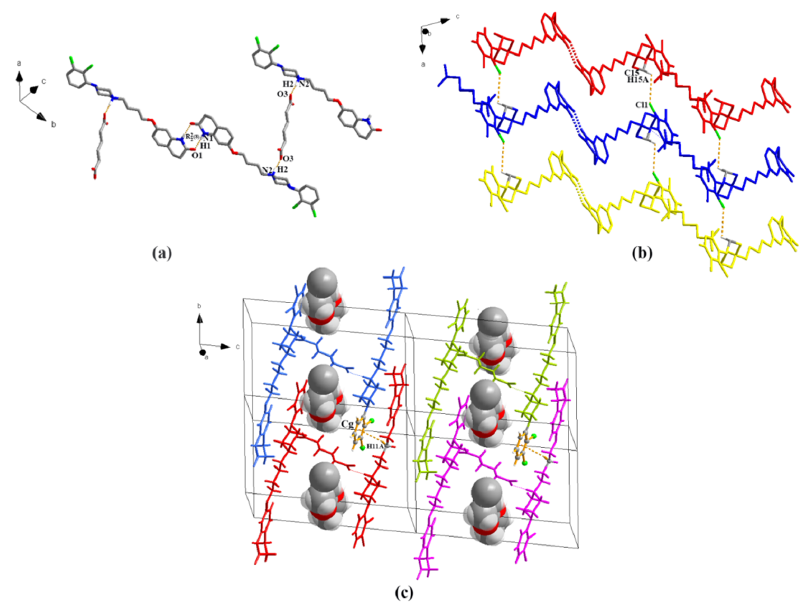
Figure 3. Packing diagrams of ARI-ADI salt acetone hemisolvate: ( a ) the 1D ribbon formed by N 1 -H 1 … O 1 and N 2 -H 2 … O 3 hydrogen bond; ( b ) the 2D sheet formed by C 15 -H 15A … Cl 1 hydrogen bond; ( c ) packing diagram for ARI-ADI salt acetone hemisolvate formed by C 11 -H 11A … Cg hydrogen bond.